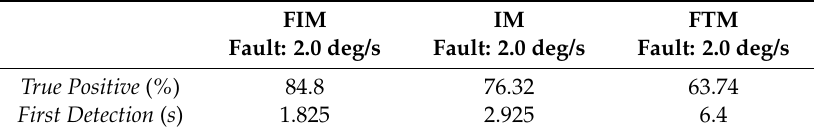
Table 8. Mean FD performance in the four validation flights for the sensor r ( k ) .